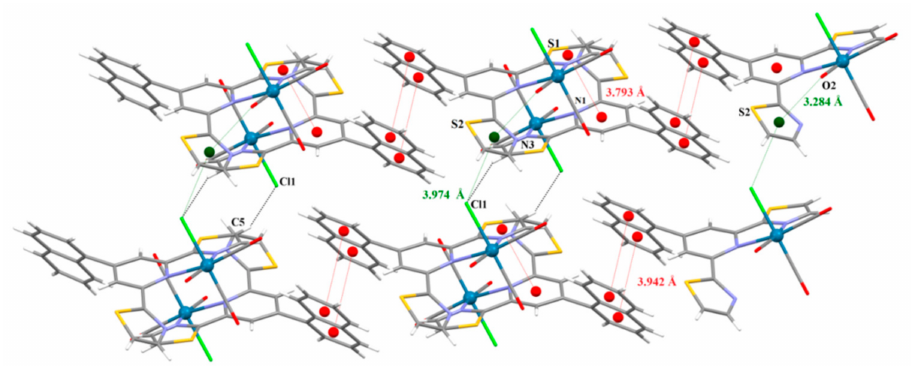
Figure 2. View of a 2D supramolecular structure of 1 arising from weak π ••• π and Y–C ••• π type interactions (red and green dashed lines). The short intramolecular contacts are indicated with black dashed lines.